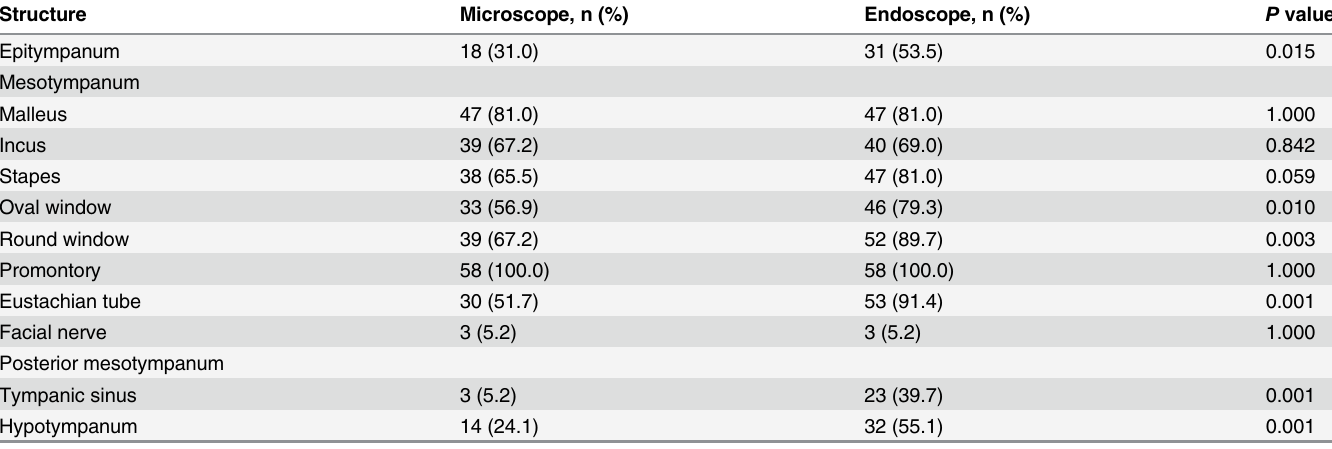
Table 1. The characteristics of the anatomical parts of the middle ear based on microscopic and endoscopic findings.